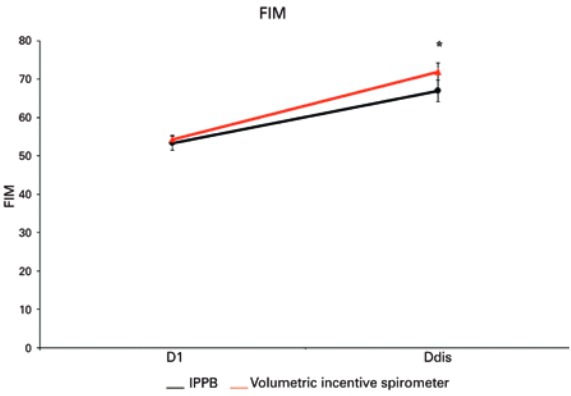
Functional Independence Measure performed on the first (D1) and last (Ddis) respiratory therapy session before discharge from the intensive care unit